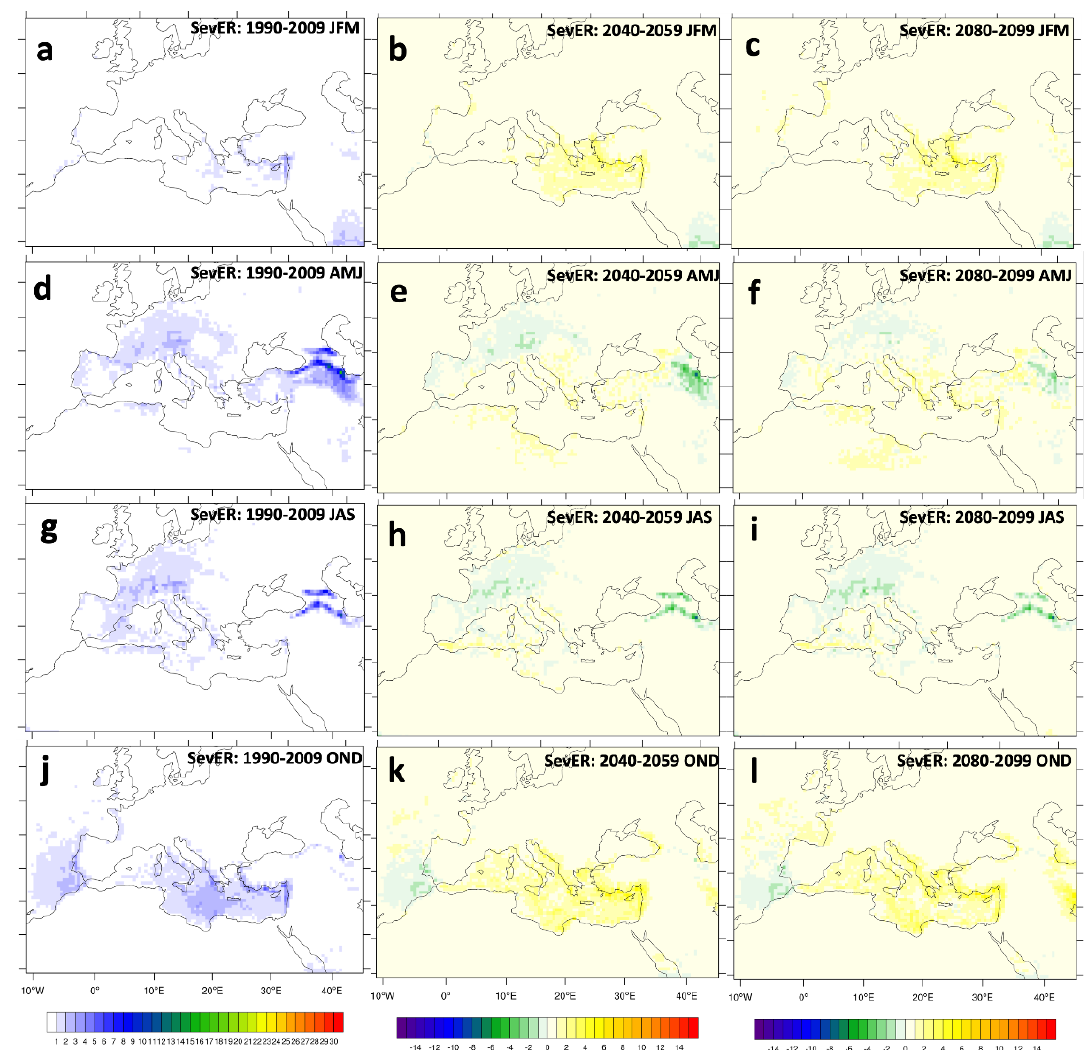
Figure 12. ( a ) Annual average number of days with CAPE ≥ 100 J / kg AND 0–6 km SHEAR ≥ 15 m / s AND convective precipitation rate > 0 mm / h (SevER) for January, February, and March (JFM) of 1990–2009, ( b ) changes in average number of days with SevER for JFM 2040–2059, ( c ) changes in average number of days with SevER for JFM 2080–2099, ( d ) annual average number of days with SevER for April, May, and June (AMJ) of 1990–2009, ( e ) changes in average number of days with SevER for AMJ 2040–2059, ( f ) changes in average number of days with SevER for AMJ 2080–2099, ( g ) annual average number of days with SevER for July, August, and September (JAS) of 1990–2009, ( h ) changes in average number of days with SevER for JAS 2040–2059, ( i ) changes in average number of days with SevER for JAS 2080–2099, ( j ) annual average number of days with SevER for October, November, and December (OND) of 1990–2009, ( k ) changes in average number of days with SevER for OND 2040–2059, ( l ) changes in average number of days with SevER for OND